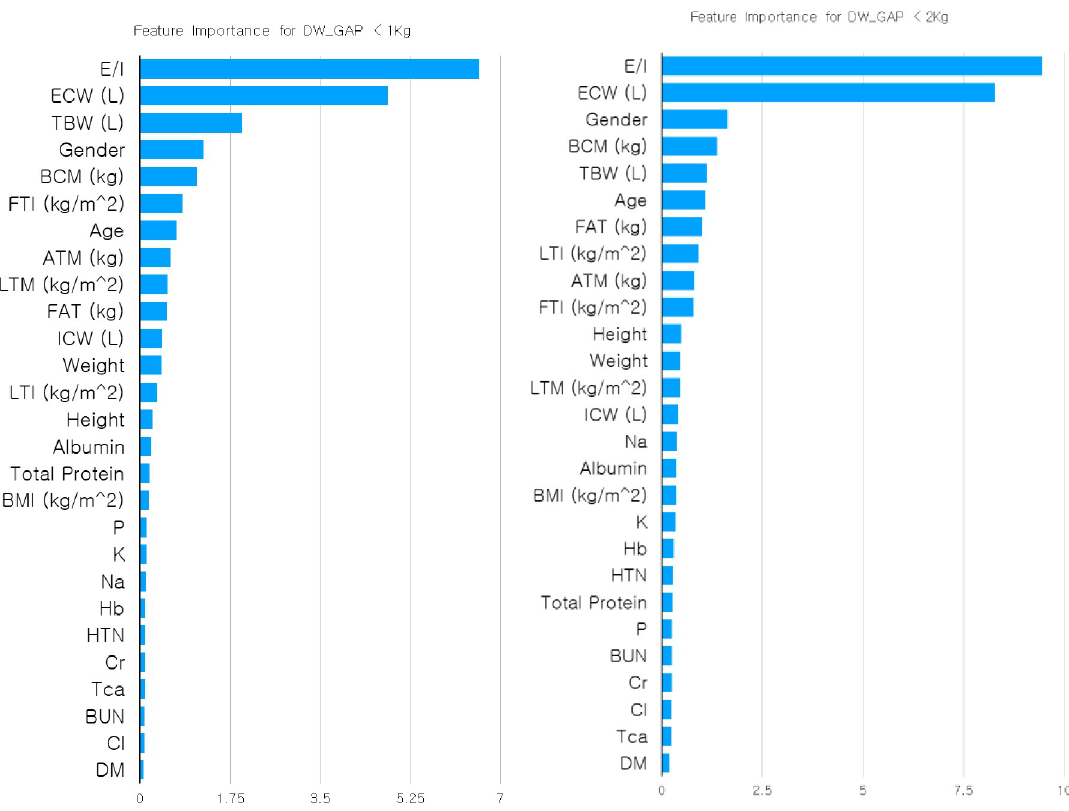
Fig 1. Feature importance for the two groups (Group 1: Gap DW < 1 kg and Group 2: Gap DW < 2 kg).